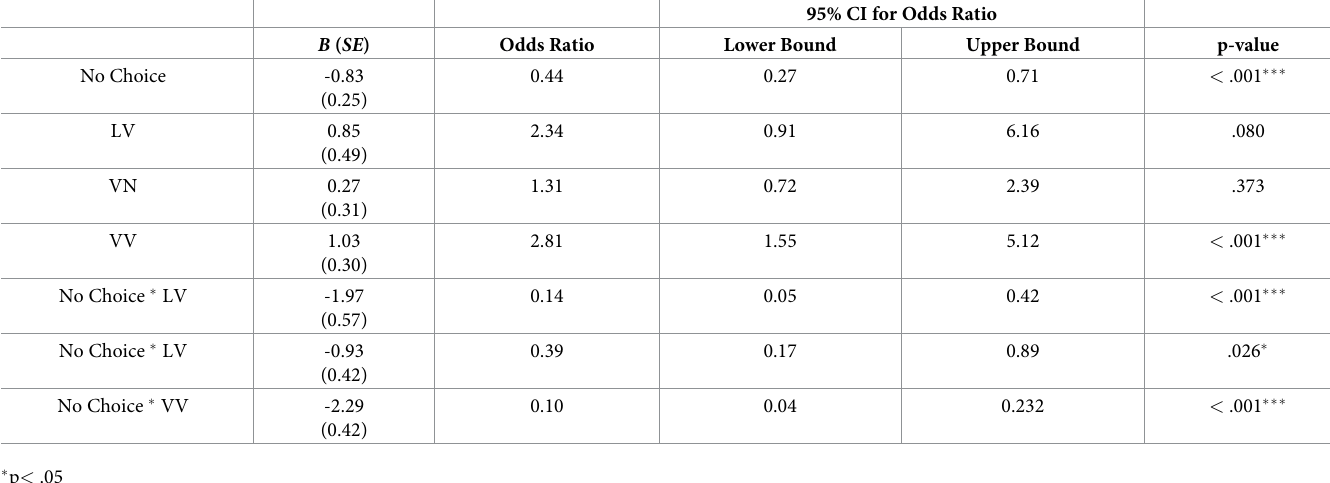
Table 8. Results of ordinal logistic regression: Effect of reader choice and story path on satisfaction.